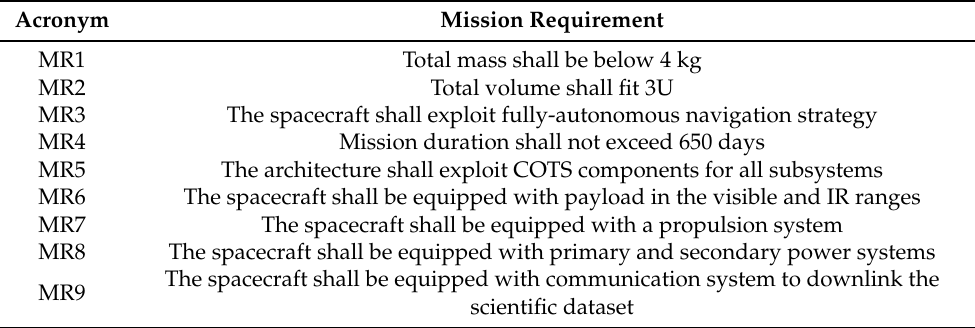
Table 1. Mission Requirements definition.